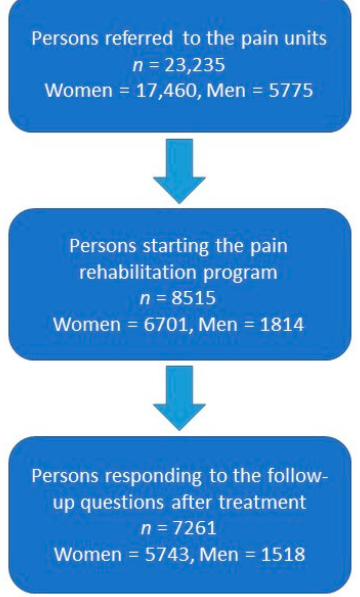
Figure 1. Flowchart of the study groups.